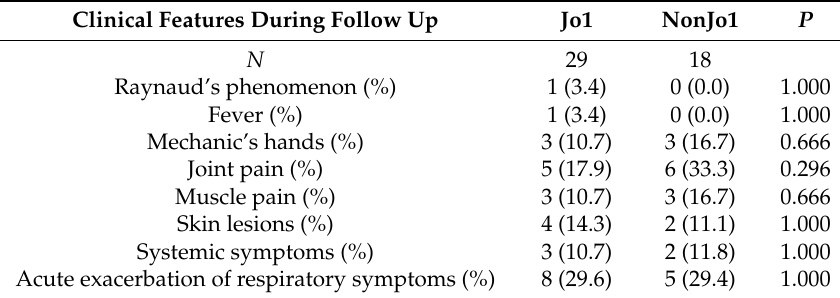
Table 2. Clinical features during follow